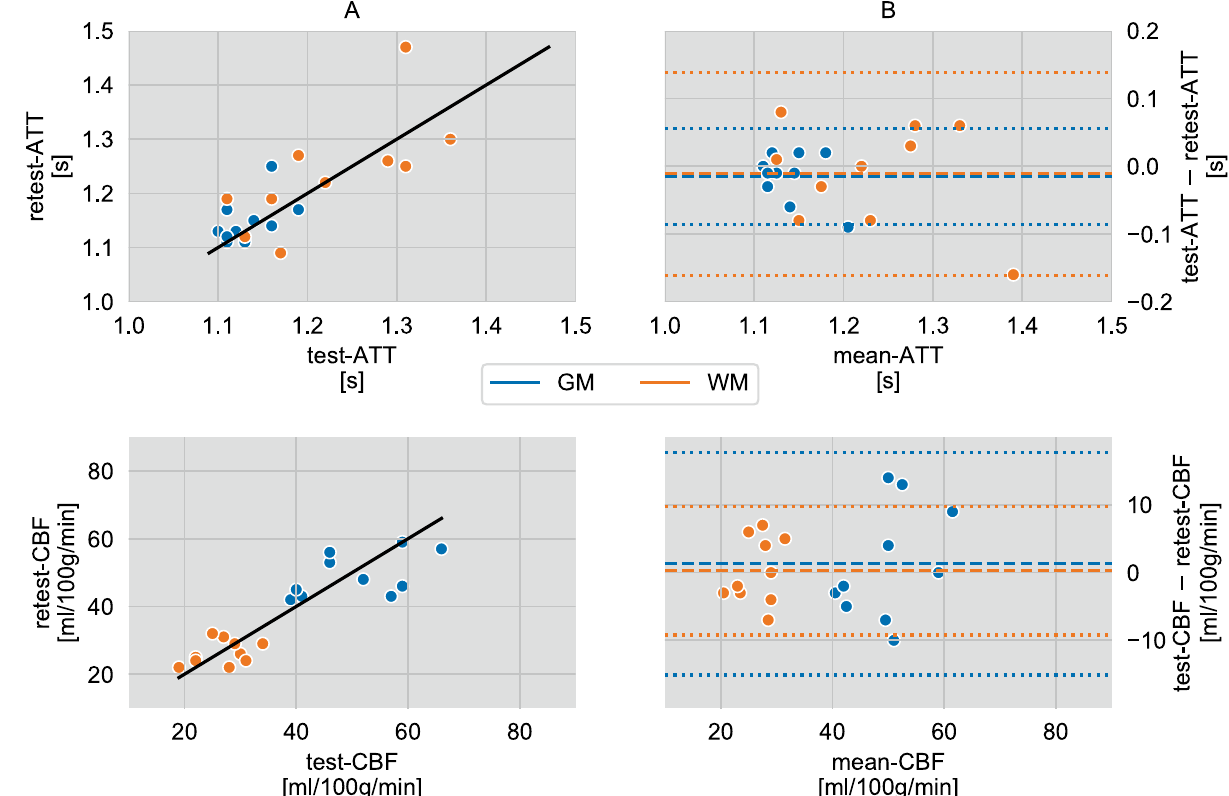
Figure 1. ( A ) Correlation of cerebral blood flow (CBF) and arterial transit time (ATT) from repeated measurements of ten subjects in gray and white matter. The solid line is the identity function and represents optimal correlation. ( B ) Agreement (Bland–Altman plot) between test and retest CBF and ATT from values shown in ( A ). The mean differences between both scans in gray and white matter are represented by the dashed line and dotted lines display the corresponding limits of agreement ( 1.96 × standard deviations of mean